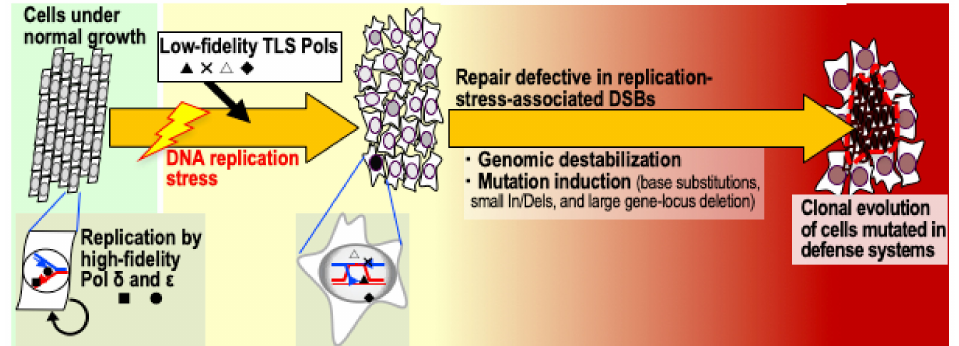
Figure 1. Model of replication-stress-triggered induction of clonal evolution through genomic destabilization. Cells that accumulate replication-stress-associated double strand breaks (DSBs) are at higher risk of genomic destabilization of either chromosomal instability (CIN) or microsatellite instability (MSI). Genomic destabilization is associated with mutation in cancer-driver genes, leading to the clonal evolution of cells with defects in cellular defense